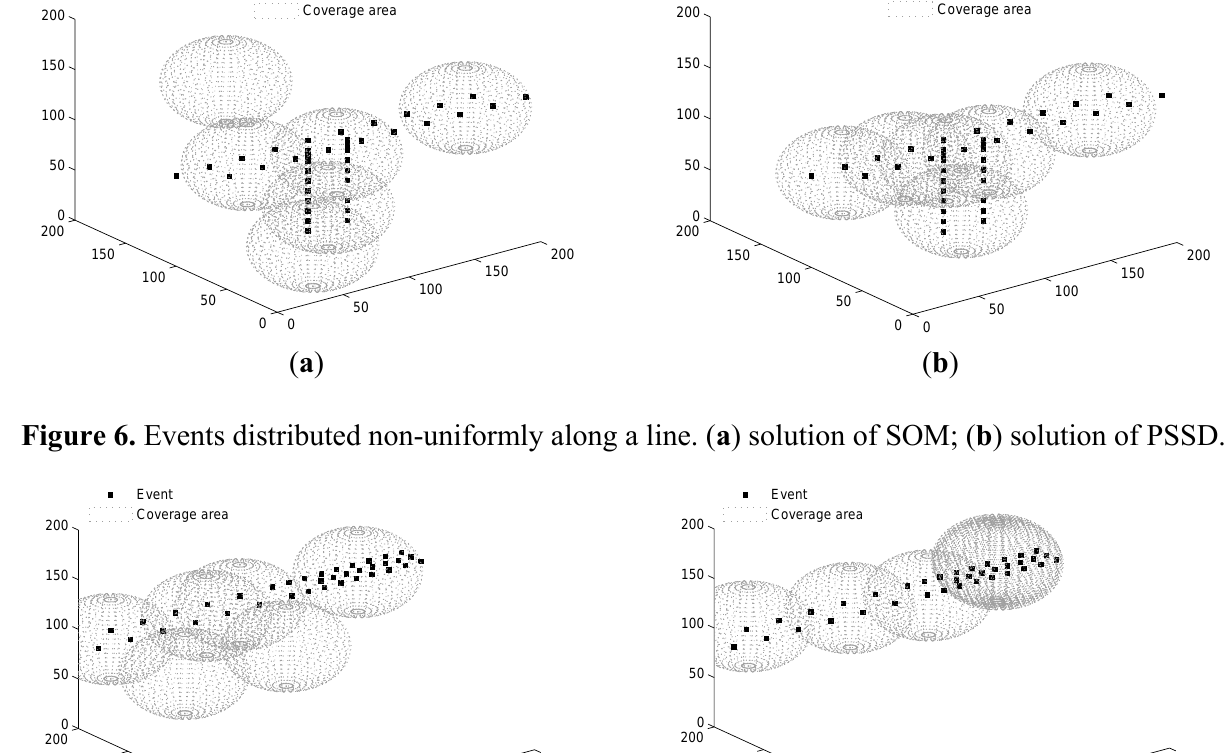
Figure 5. Events distributed non-uniformly in T-shape. ( a ) solution of SOM; ( b ) solution of PSSD.